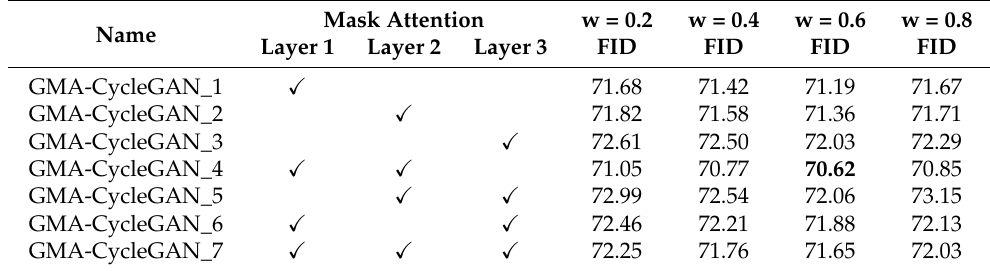
Table 1. Results of the FID after that the mask attention was inserted into different layers.